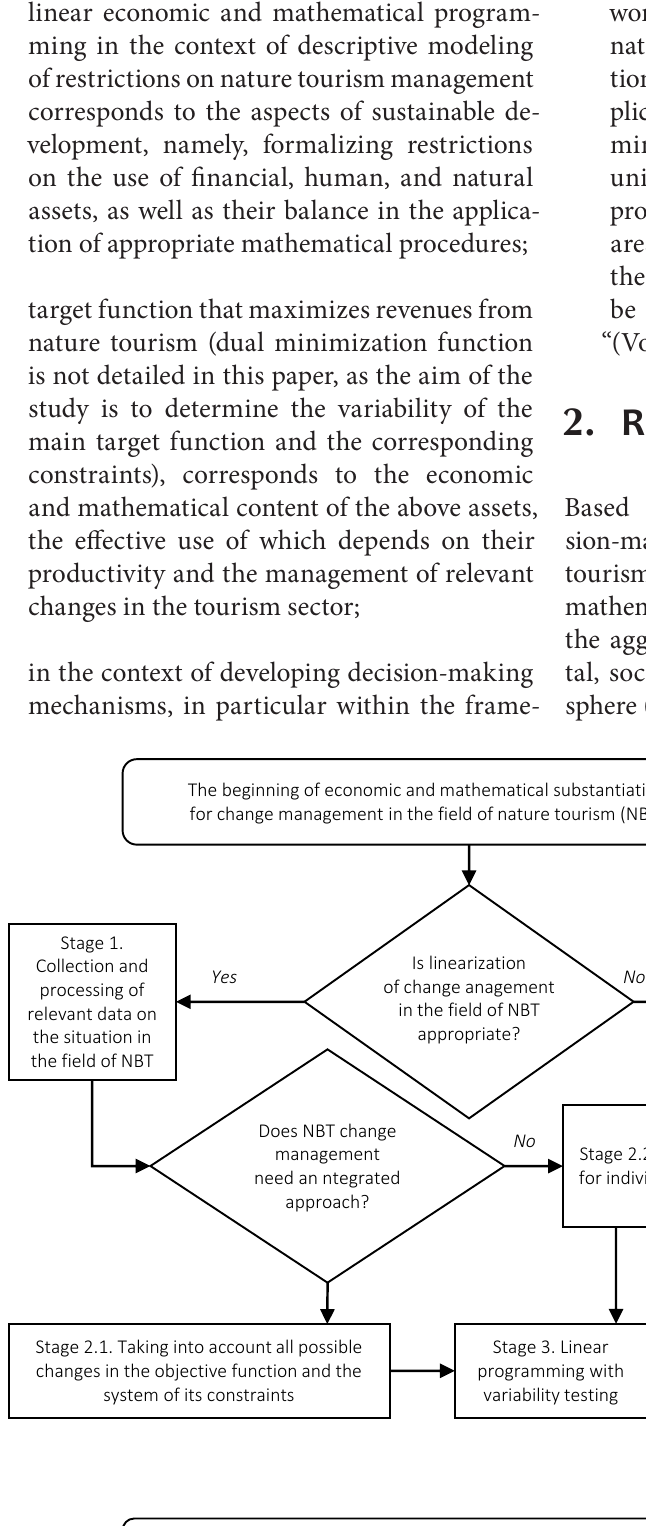
Stage 3. Linear programming with variability testing